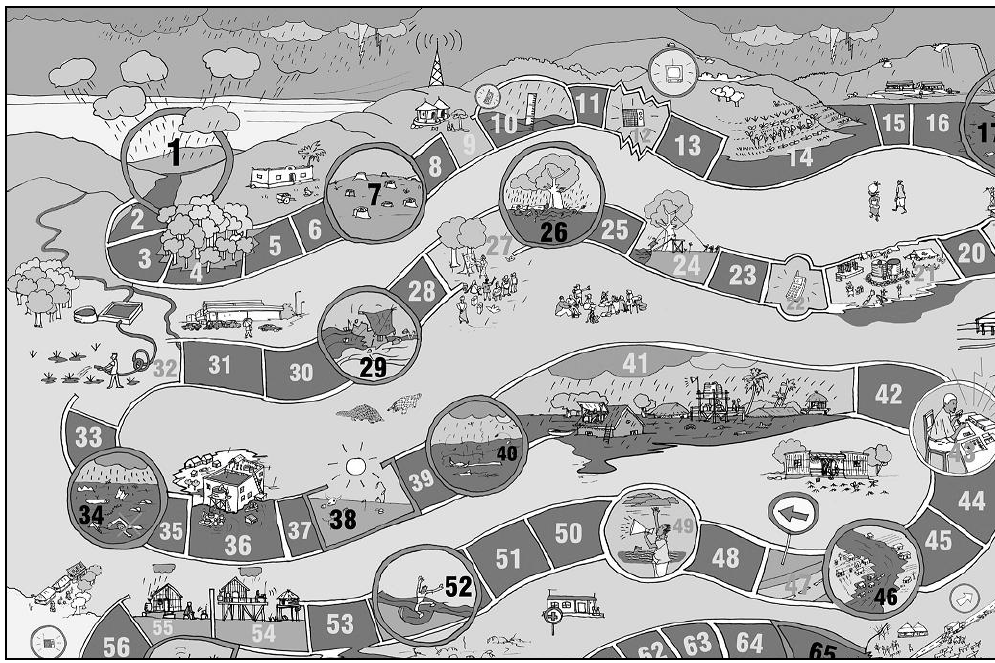
Figure 10. The River